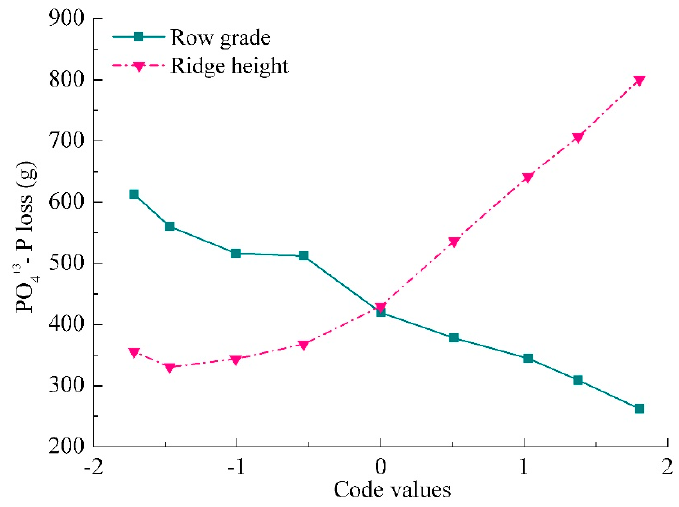
Figure 9. Mono-factor effect curves of ridge height and row grade for PO 4+3 –P loss.